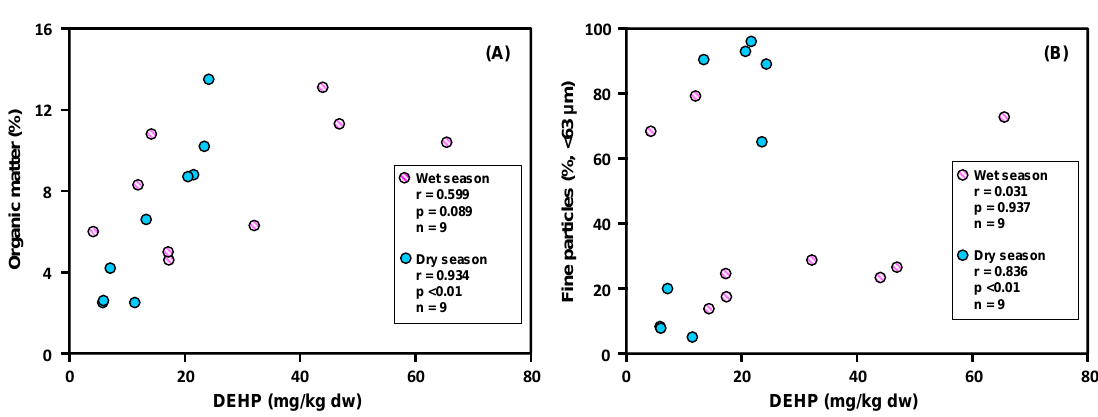
Figure 3. Correlations between DEHP concentrations and ( A ) organic matter as well as ( B ) fine particles in the sediments of Love River during the dry and wet seasons (data from L10 were not include in the correlation analysis, n = 9).